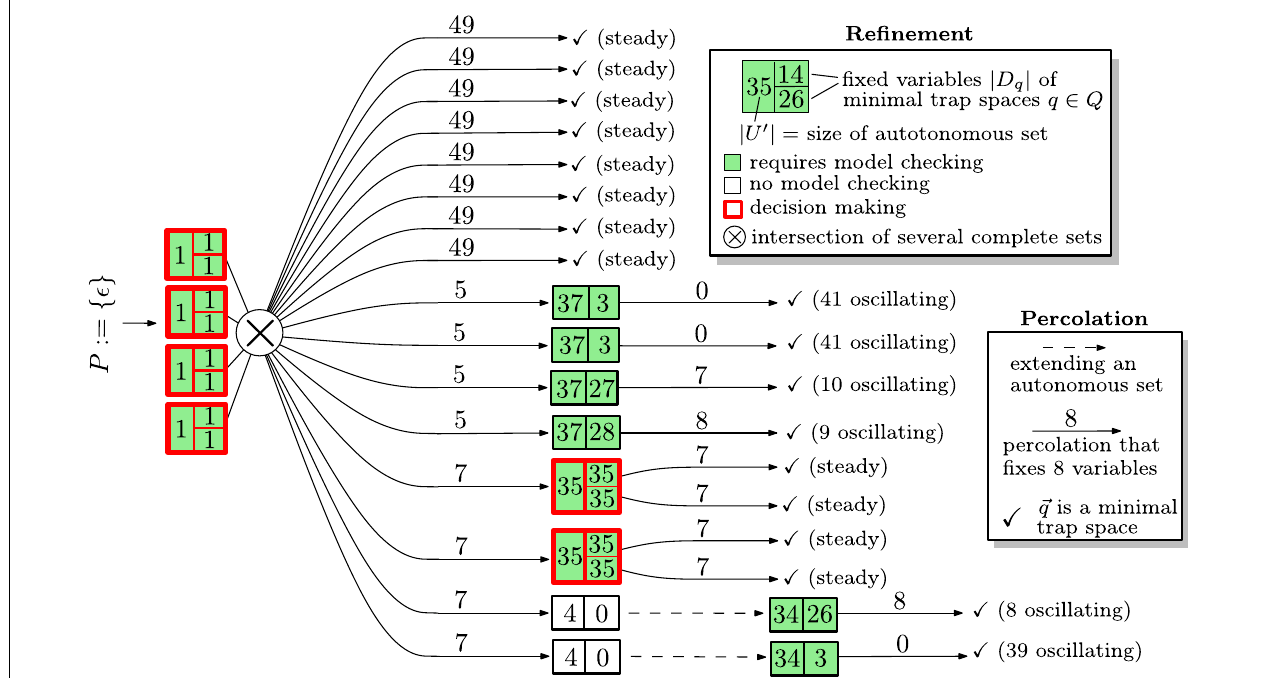
FIGURE 4 | An illustration of the how the iterative refinement algorithm confirms that min ( S ⋆ F ) of the MAPK network is complete . Altogether 12 restricted systems are model checked instead of the single full system. A more detailed description is given in the main text.